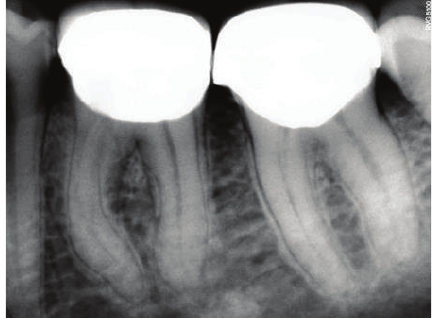
Figure 22: 12-month followup RVG: 36, 37.